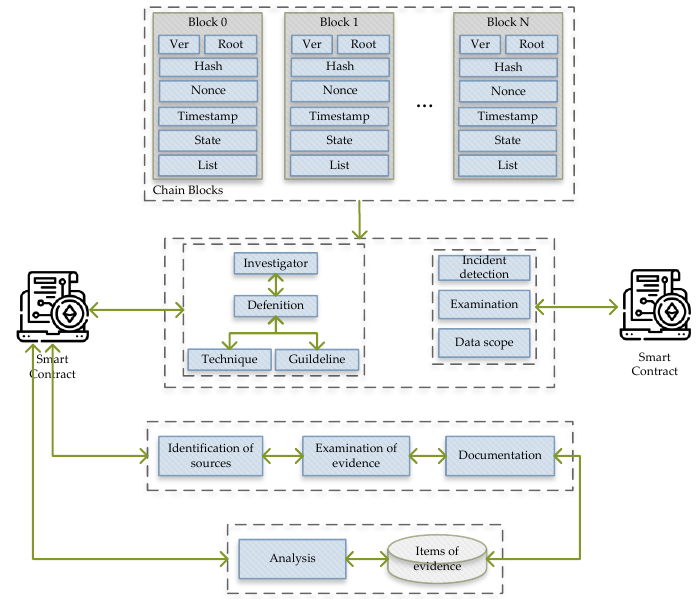
Figure 3. Blockchain-based evidence